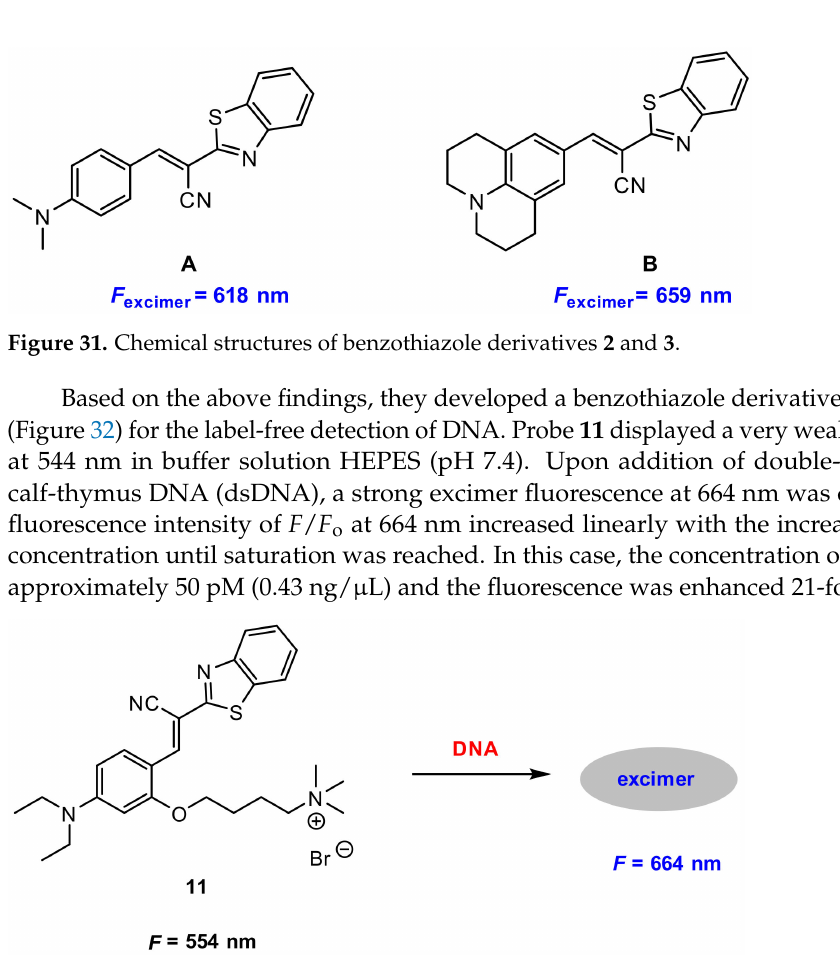
Figure 32. Chemical structure of 11 and its response to DNA.